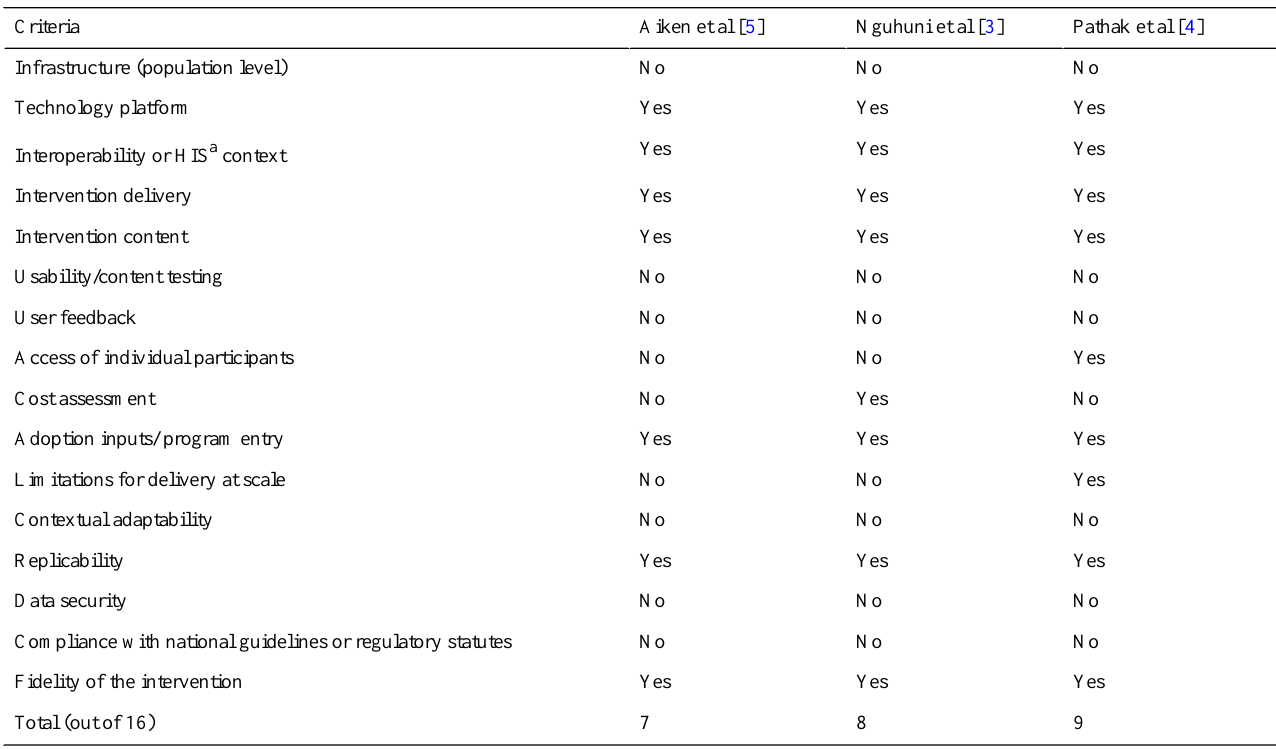
Table 4. Mobile health evidence and reporting assessment